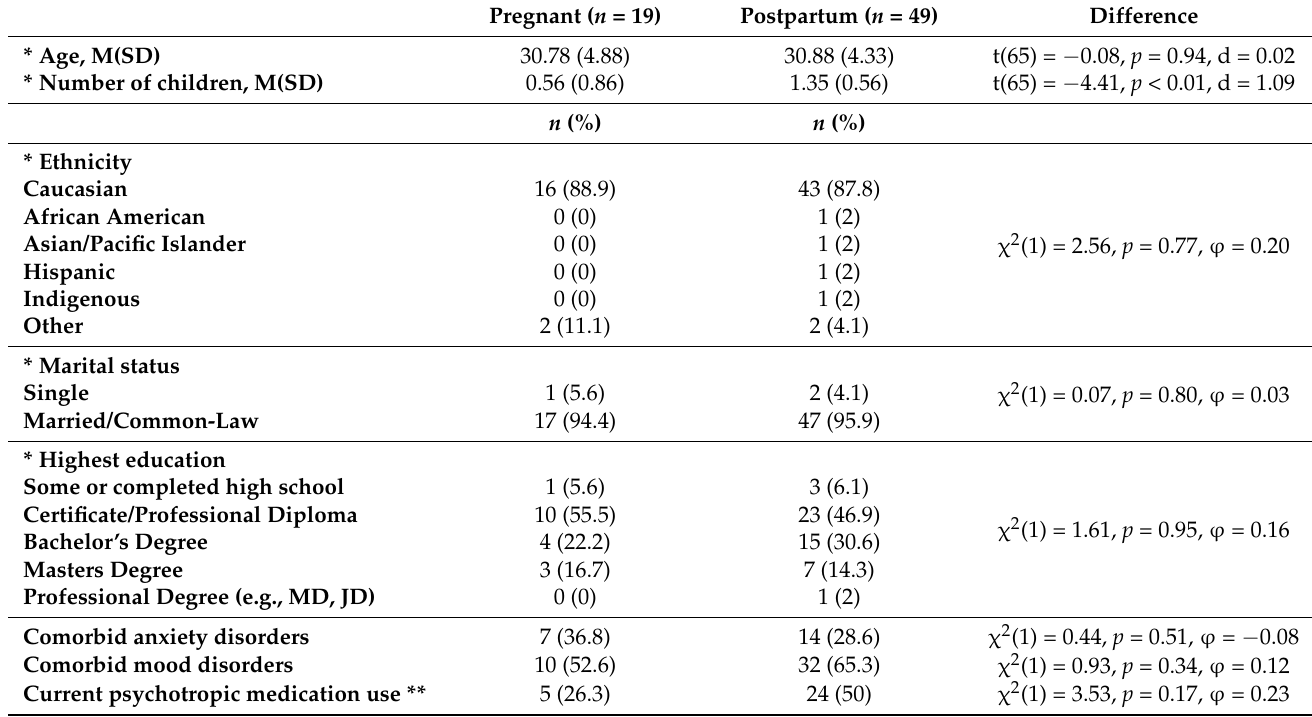
Table 1. Participant Demographics and